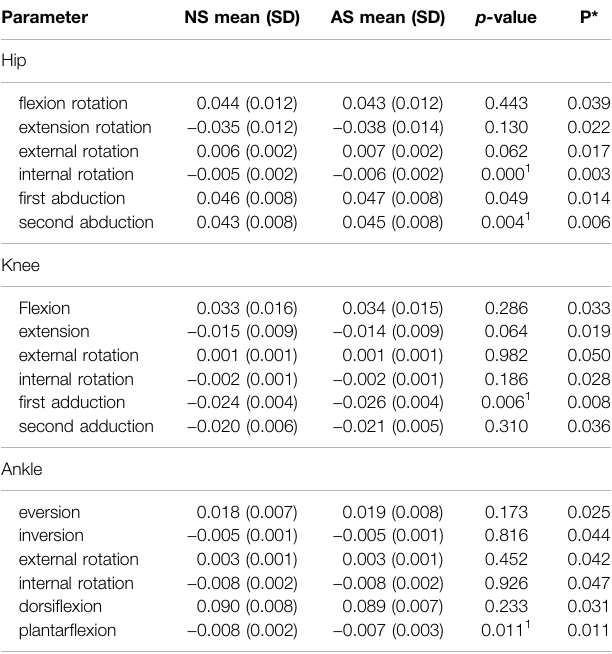
TABLE 2 | Peak moments of lower limb joints for NS and AS during stance (BW and · BH).